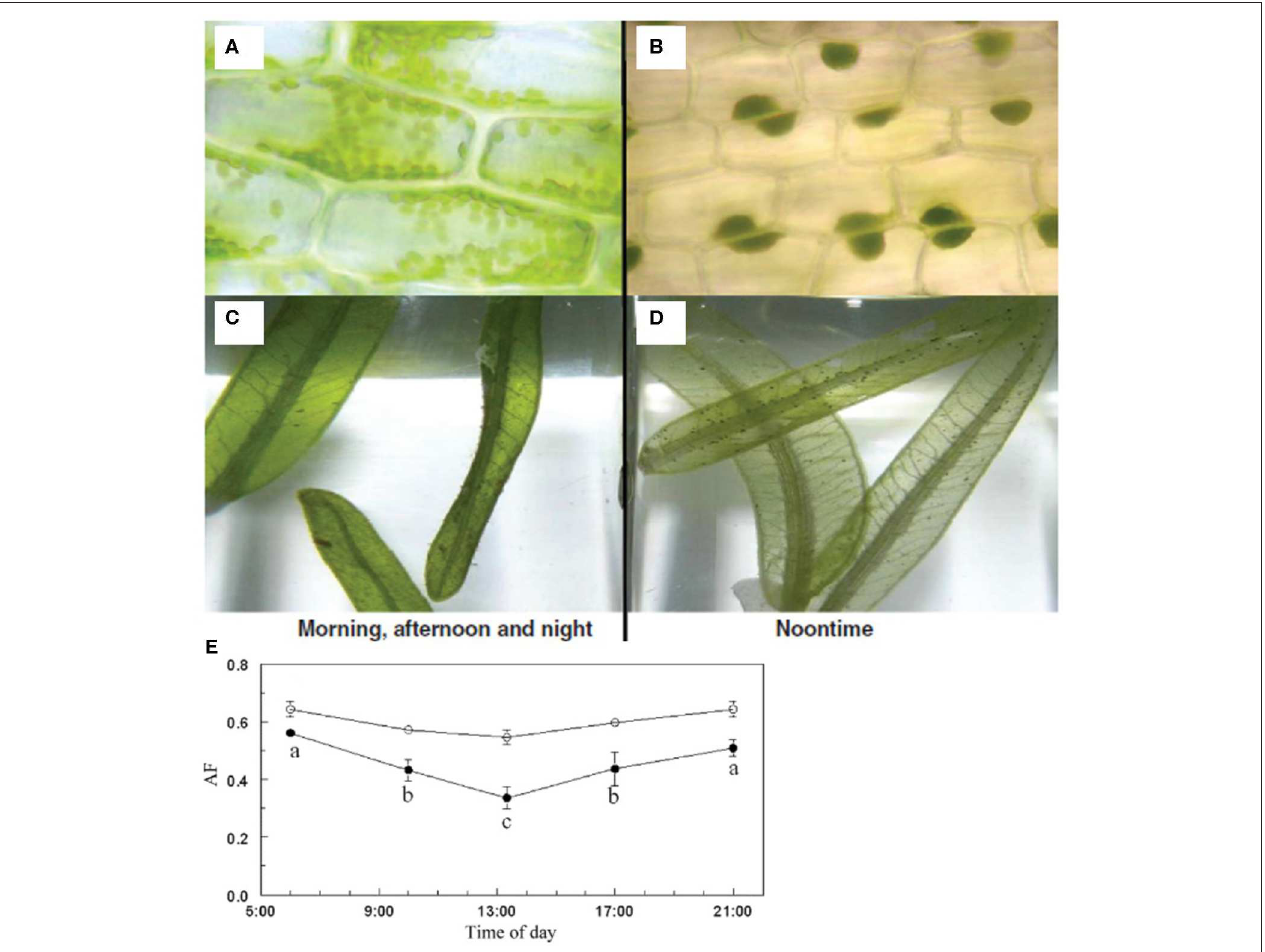
FIGURE 7 | Chloroplast clumping in Halophila stipulacea . Microscope pictures (A,B) and whole-leaf pictures (C,D) of H. stipulacea leaves growing in low and high light environments. The chloroplasts (residing mainly in the epidermis) are diffused throughout the cells’ cytoplasm at low irradiance (A,C) , thus leaves appear dark green. In contrast, the chloroplast clump together (B,D) in shallow high-light growing plants, thus leaves appear more transparent. The chlorophyll content per leaf area is the same in (A–D) , but the difference in color is due to clumping of the chloroplasts, entailing less light-absorption and more photoprotection (from Beer et al., 2014). (E) Daily changes in absorption factor (AF, n = 10) of H. stipulacea grown on a sunlit water table under shading nets at ∼ 150 (open circles) and ∼ 450 (closed circles) µ mol photons m − 2 s − 1 during midday. Significant differences ( p < 0.01, one-way ANOVA) along the day are indicated with different letters (adapted from Sharon